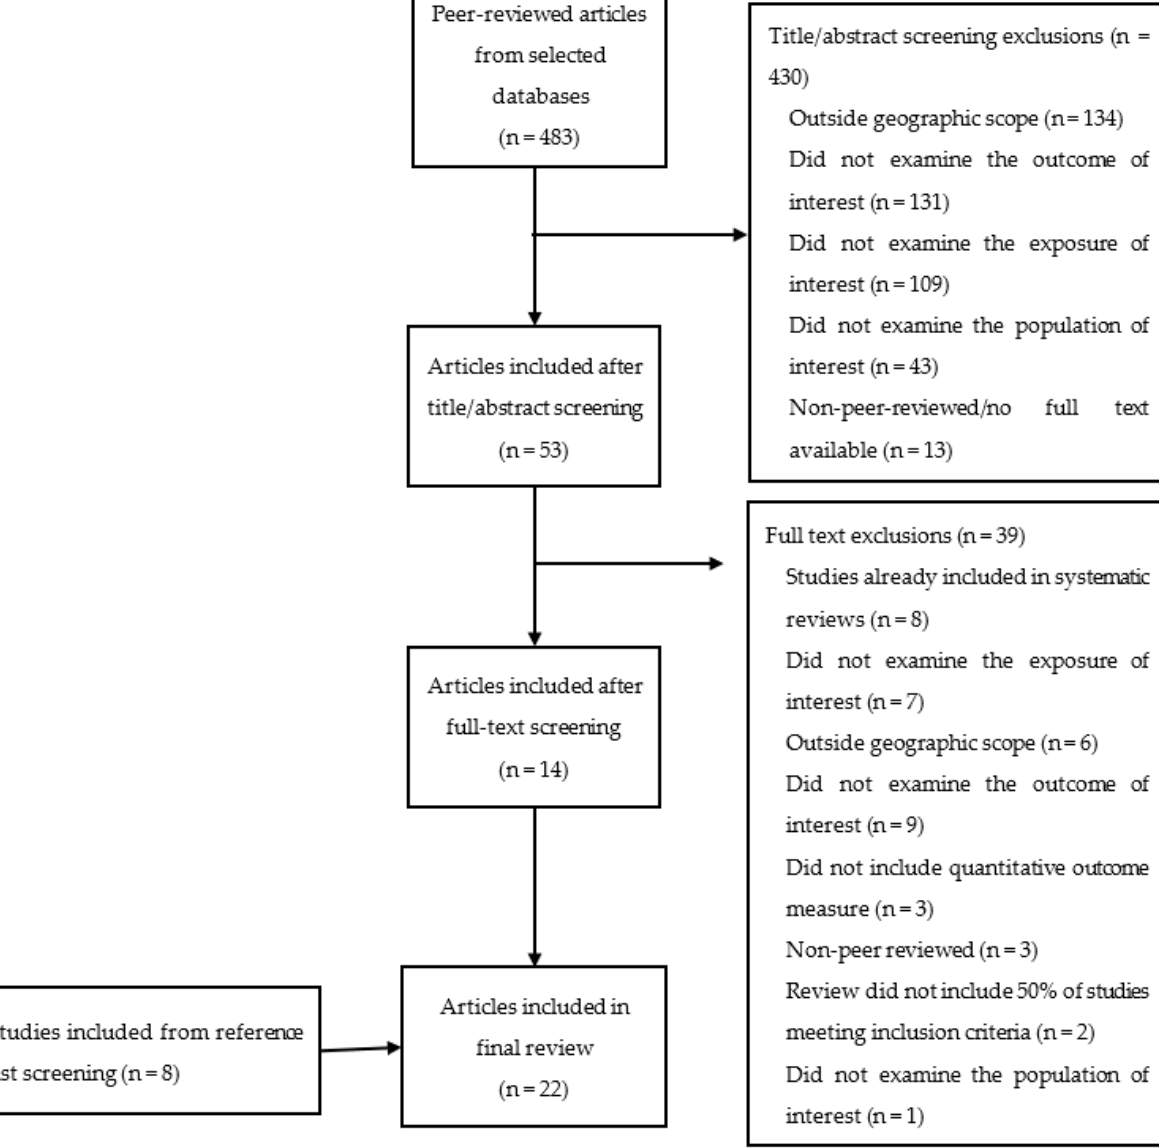
Figure 1. Prisma-ScR Flow diagram for included and excluded studies.